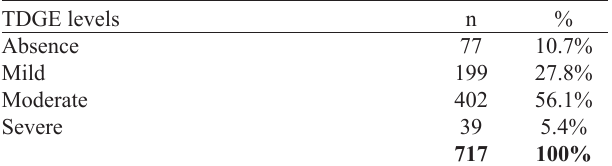
Table 1. Data of heart procedures. Table 2. The impact of postoperative TDGE.